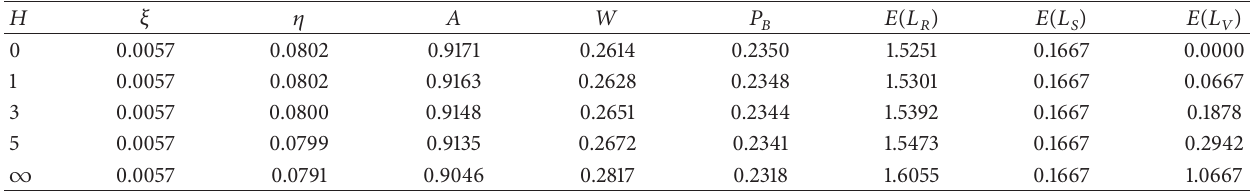
Table 1: Main reliability indices of production line for different maximum part-time job number 𝐻 with (𝜆,𝑟, 𝜃, 𝛼,𝛽) = (3,15, 6, 0.35, 14) .